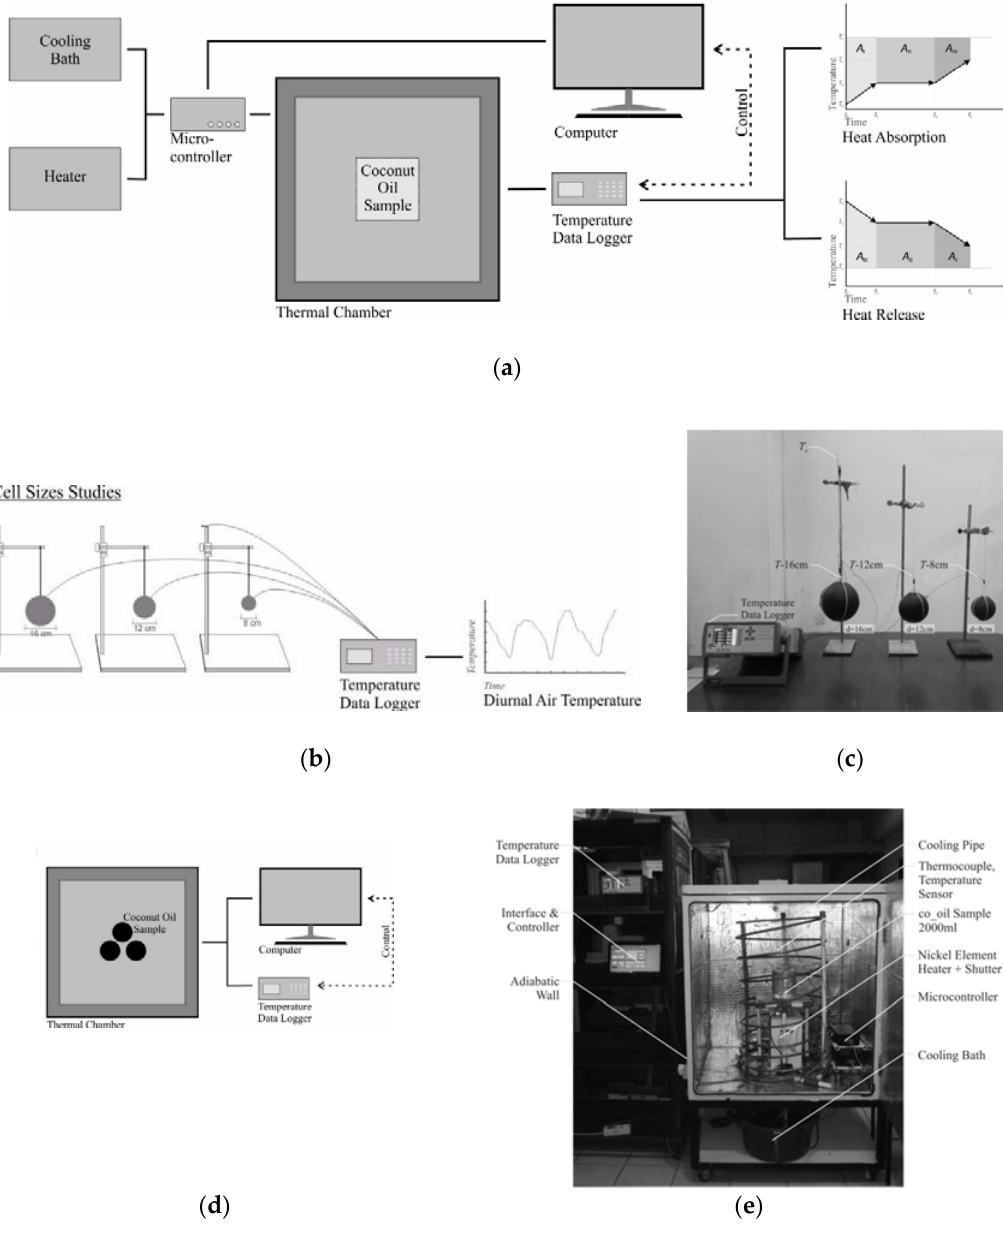
Figure 2. ( a ) The schematic diagram for heat absorption and release measurement. ( b ) The schematic diagram for the cell sizes studies, and ( c ) the photograph of coconut oil cell. ( d ) The schematic diagram for the measurement in the thermal chamber, and ( e ) the photograph of the thermal chamber.